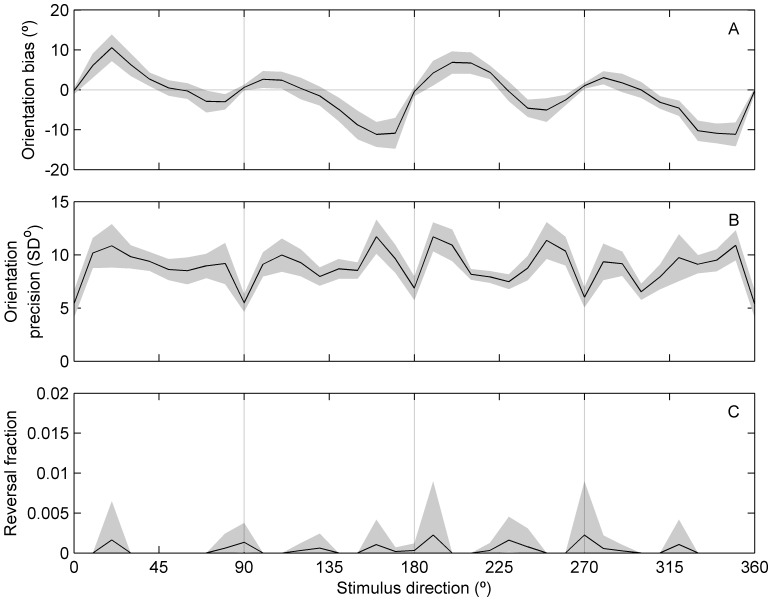
Direction-dependent perceptual performance.Bias, precision and reversal fraction have an anisotropic dependence on stimulus direction. All results show mean ± SE across 12 participants, based on the control data from Experiment 1 (stimulus duration of 160 ms). (A) Perceptual repulsion from horizontal directions is evident as the large positive slopes near 0 and 180°, and the smaller, but still positive slopes near 90 and 270°. (B) The oblique effect is apparent as the higher precision (standard deviation) for oblique directions compared to cardinal directions. (C) Reversals were negligible due to the long stimulus duration.